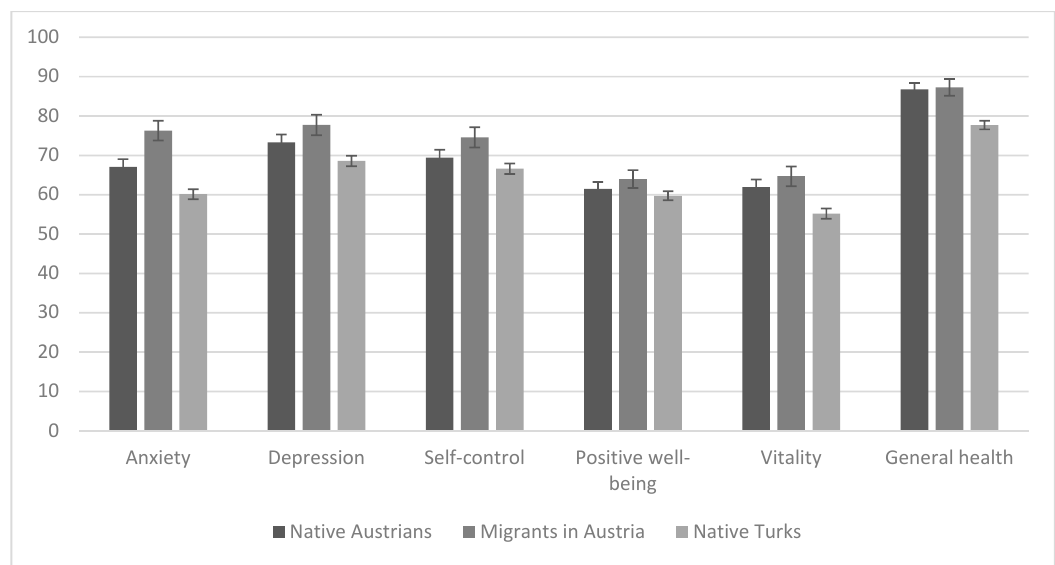
Figure 2. Subscales of the psychological general well-being index with M and SEM in the different groups. The means are depicted after controlling for the effect of age and gender. Higher scores indicate more well-being (i.e., lower levels of anxiety but higher levels of vitality). The y-axis indicates the possible values of the scores of the subscales. Table 1. MANCOVA results regarding group comparisons of the psychological general well-being index separately depicted with the factors financial problems and current treatment.